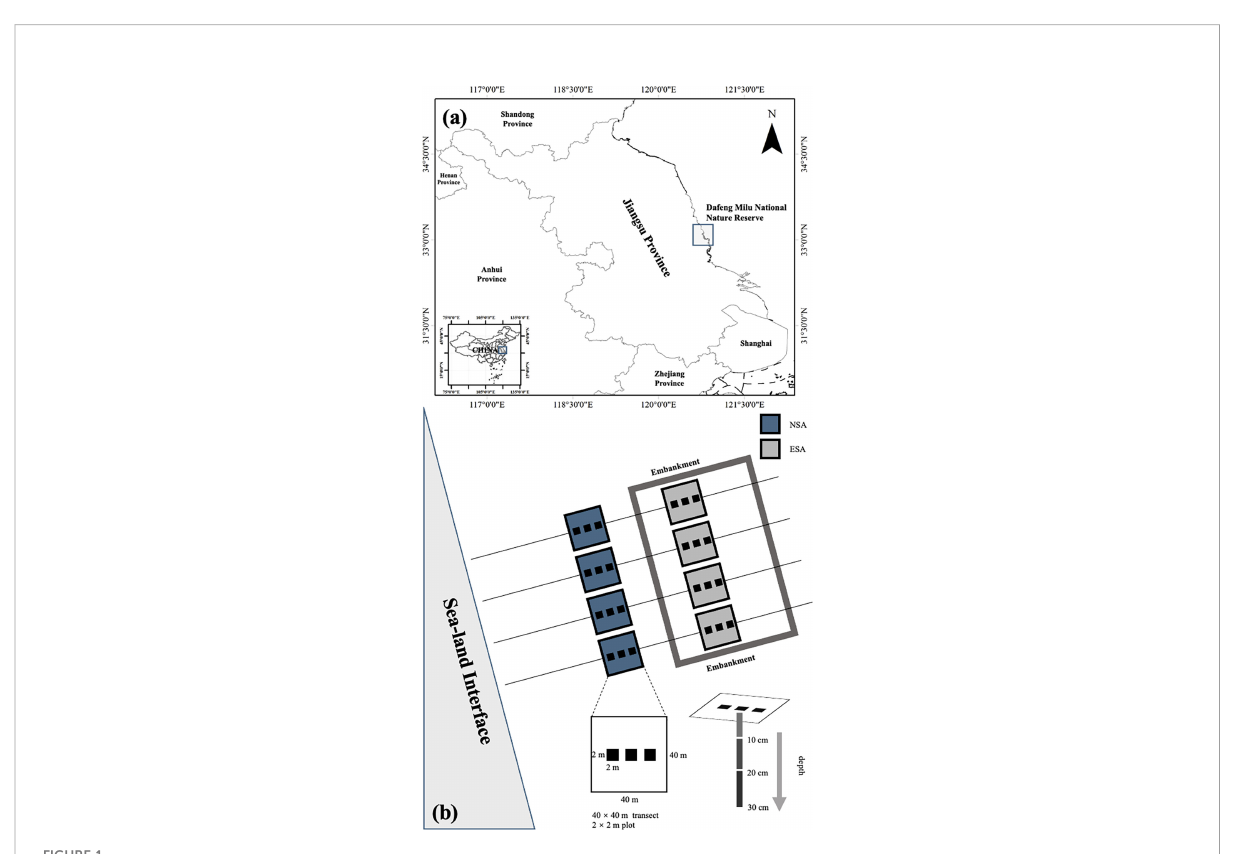
FIGURE 1 (A) Location of the study site and (B) schematic diagram of the study area in Dafeng Milu National Nature Reserve, Yancheng, Jiangsu Province, China. NSA, natural Spartina alterni fl ora salt marsh; ESA, embanked S. alterni fl ora salt